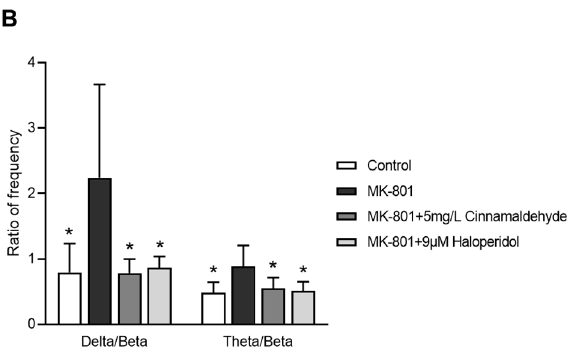
Figure 8. Effects of cinnamaldehyde on EEG in an MK-801-induced anxiety-like model in zebrafish. ( A ) Heat map representing EEG relative power spectrum. ( B ) Theta/beta and delta/beta ratios were calculated. EEG: electroencephalogram. Data represent means ± SDs ( n = 6 per group). * p < 0.05, ** p < 0.01 vs. the MK-801 group.